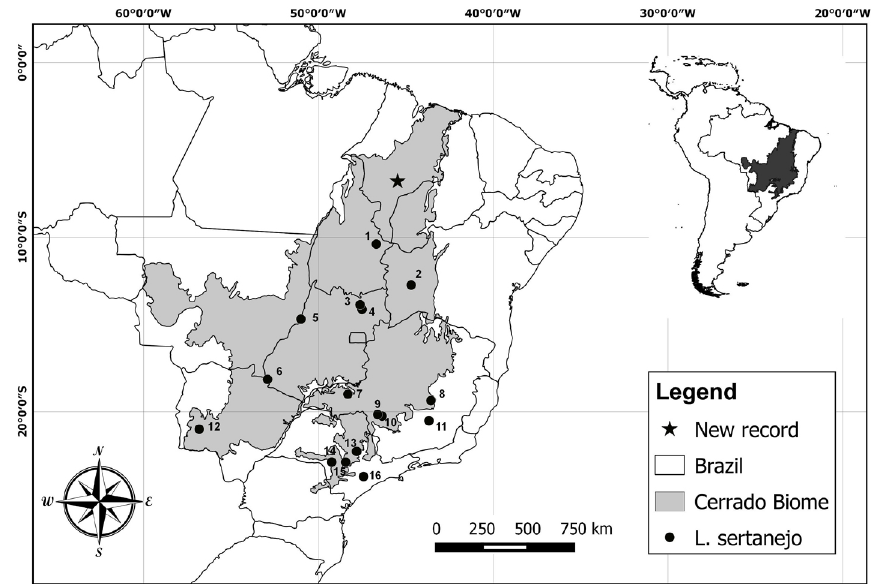
Figure 3. Geographic distribution of Leptodactylus sertanejo in the Brazilian Cerrado Biome. Black star represents the new record for the state of Mara- nhão. Black circles represent the literature records: 1 - Estação Ecológica Serra Geral do Tocantins (Valdujo et al. 2011); 2 - São Desidério (Valdujo et al. 2009); 3 - Parque Nacional Chapada dos Veadeiros (Santoro and Brandão 2014); 4 - Alto Paraíso de Goiás (Carvalho et al. 2013); 5 - Reserva Extrativista Lago do Cedro (Melo et al. 2013); 6 - Parque Nacional da Emas (Kopp et al. 2010); 7 - Uberlândia (Giaretta and Costa 2007); 8 – Parque Nacional da Serra do Cipó (Sazima and Bokermann 1978); 9 - Parque Nacional da Serra da Canastra (Haddad et al. 1988); 10 - São Roque de Minas (Carvalho et al. 2013); 11 - Ouro Branco (São-Pedro and Feio 2011); 12 - Parque Nacional da Serra da Bodoquena (Uetanabaro et al. 2007); 13 - Estação Ecológica de